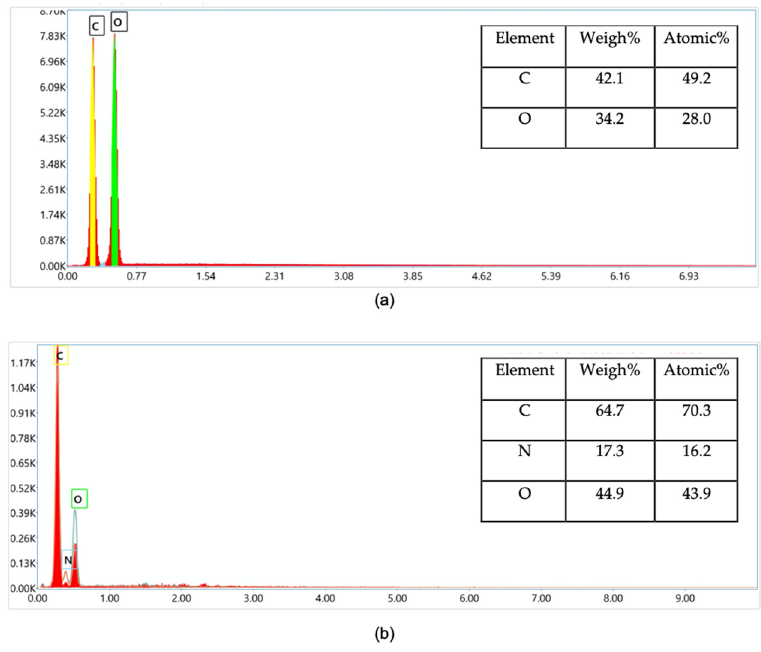
Figure 10. EDS spectra of ( a ) native starch and ( b ) grafted starch.